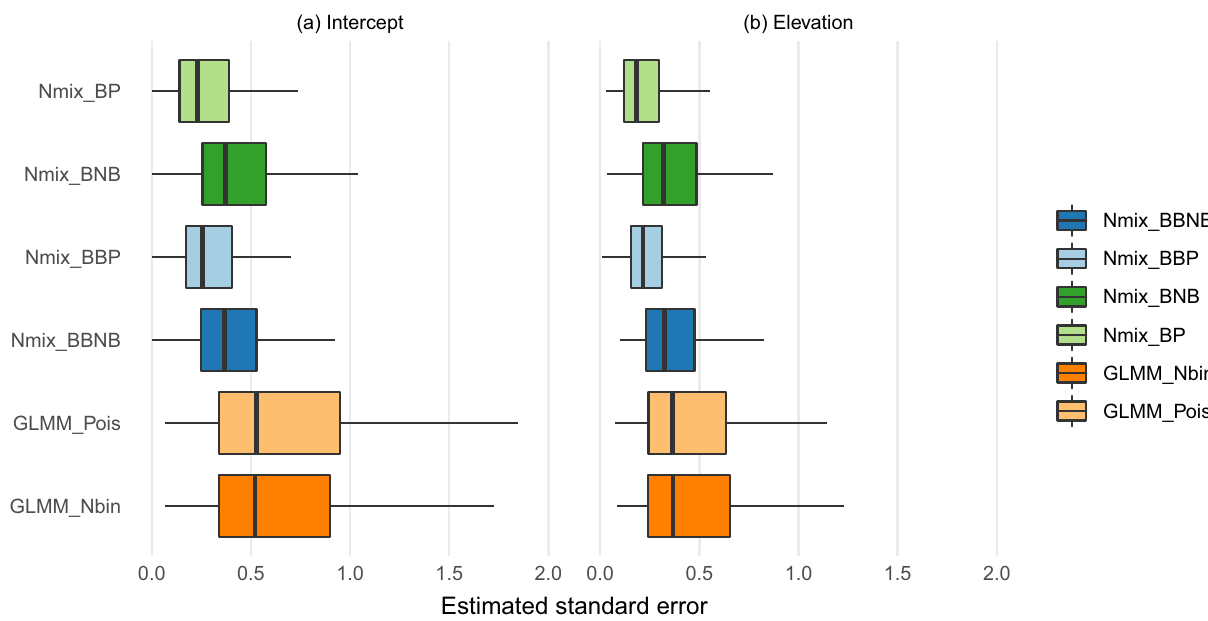
Figure 5. Comparing standard errors of estimates of the data intercept (defined as expected log count at a standard site) and a relative abundance driver of interest, elevation. Outliers are excluded for